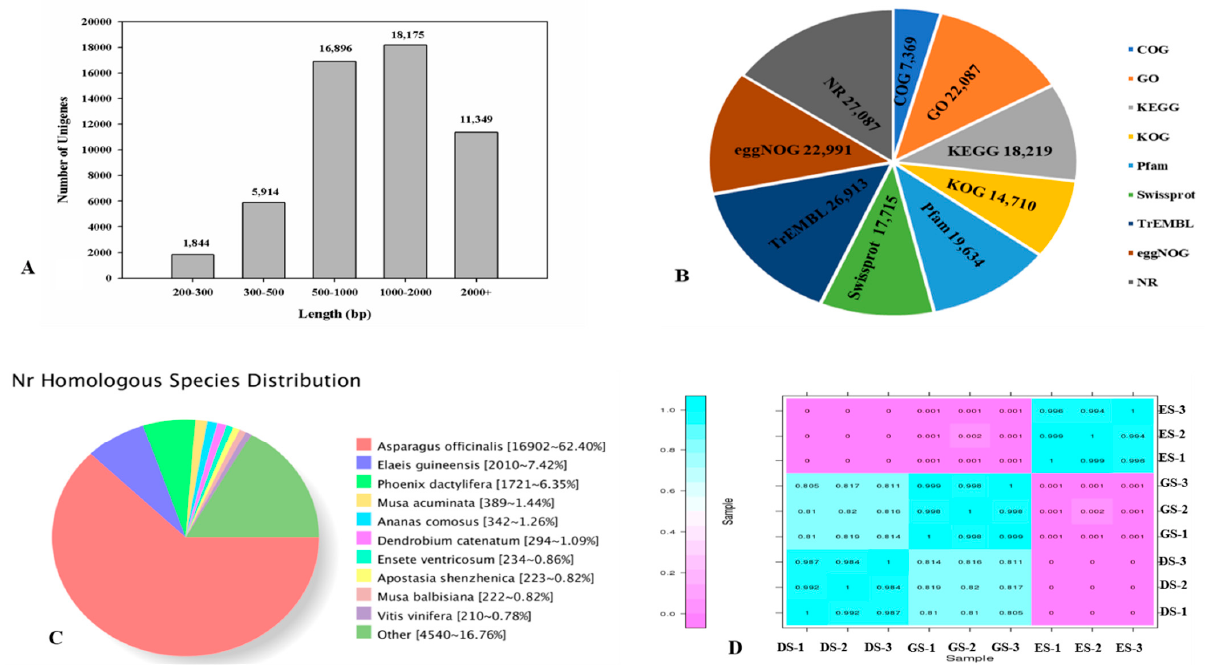
Figure 3. Characteristics of unigenes generated by Illumina sequencing. ( A ) The length distribution of unigenes in P. cyrtonema Hua. ( B ) The annotation of unigenes among databases. ( C ) Species distribution of all annotated unigenes. ( D ) Correlation analysis of the samples. Unigenes with q value < 0.05 and |log2FC| ≥ 1 were defined as DEGs. Among the DEGs, 2543 and 6941 were upregulated, and 2510 and 5041 genes were downregulated at